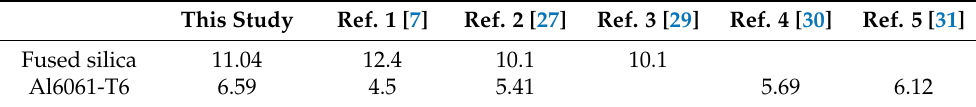
Table 1. Absolute acoustic nonlinearity values of this study and key